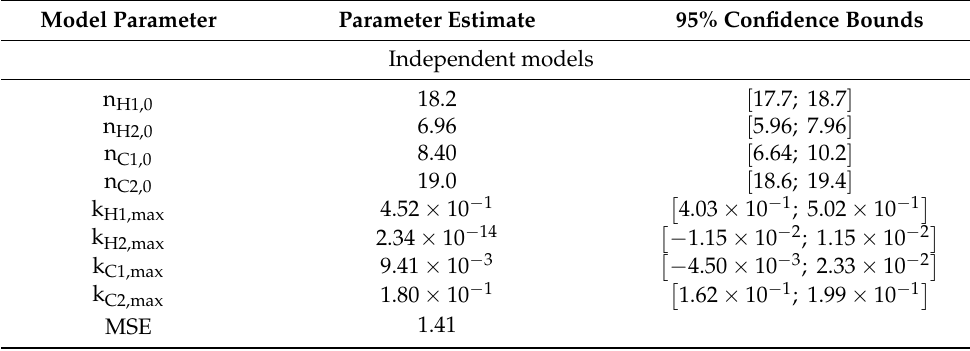
Table 2. Parameter estimation results from fitting the independent models (Equations (24) to (27)) and sublethal injury model (Equations (28) to (31)) based on biphasic inactivation on Dataset